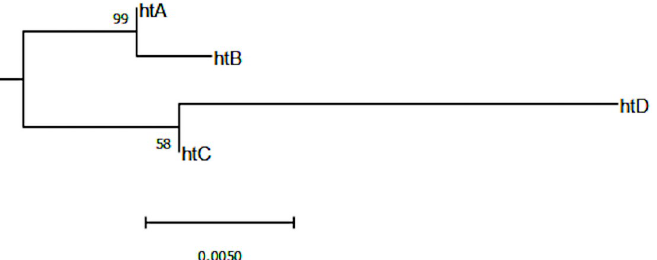
Fig 4. Phylogenetic reconstruction of the ca . Erwinia dacicola fragment sequence (814 bp after quality trimming and alignment) of the 16S recombinant deoxyribonucleic acid (rDNA) gene. Three other Erwinia sequences (KC139453, E . persicina ; KT766070 E . aphidicola ; JX867759, E . piriflorinigrans ) were used to root the phylogeny (not shown). The tree with the highest log likelihood (-1304.66) is shown together with the percentage of trees in which the associated taxa clustered together (next to the branches, 1000 replicates). The selected Hasegawa-Kishino-Yano model with a discrete Gamma distribution was used to model evolutionary rate differences among sites (+G, parameter = 0.05). The tree is drawn to scale, with branch lengths measured in the number of substitutions per site.